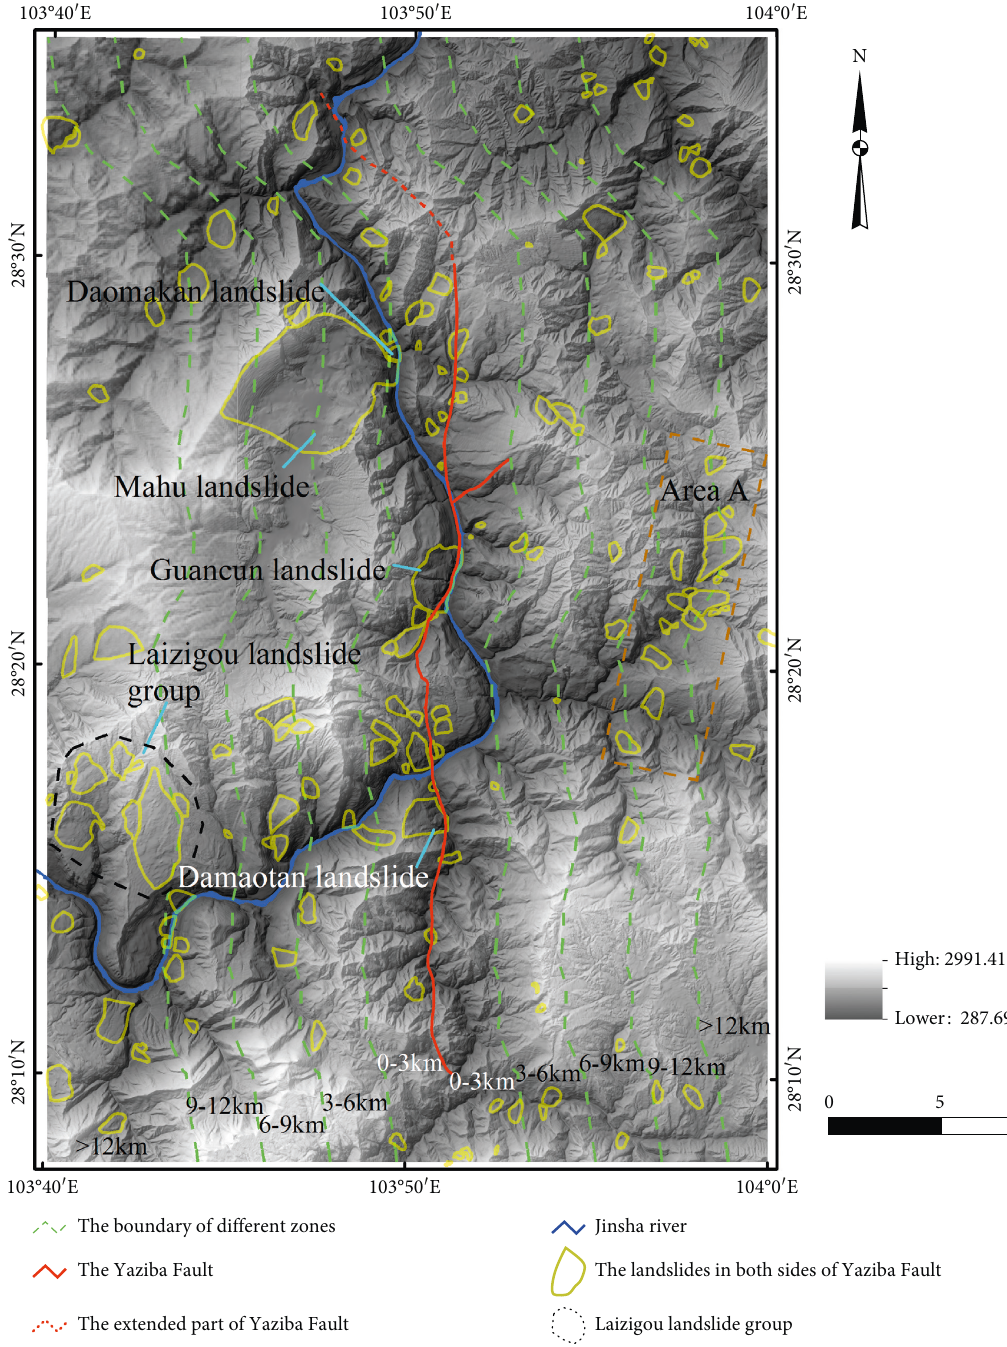
Figure 8: Landslides near the Yaziba